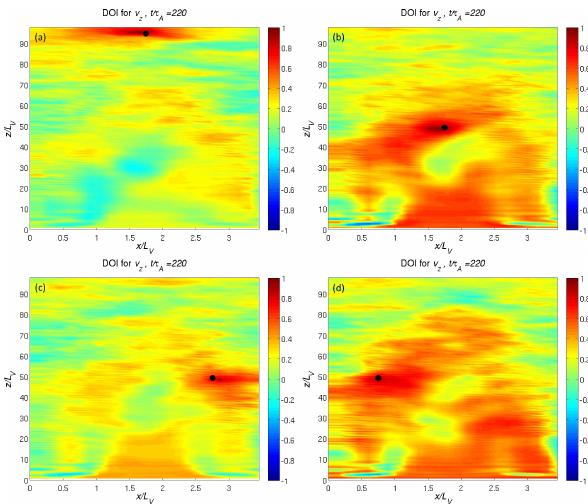
Fig. 9. Domain of influence for the z component of the solar wind velocity v z for the assimilation of a velocity observation taken at different locations at the same time step t/τ A = 220. The black cir- cle indicates the data observation location. (a) refers to location 4 (L1, 1 AU), (b) to location 3, (c) to location 5 and (d) to location 6. The spatial dimensions are normalised to L v = L B , the length scale of variation of the velocity; time is normalised to the Alfvén time τ A